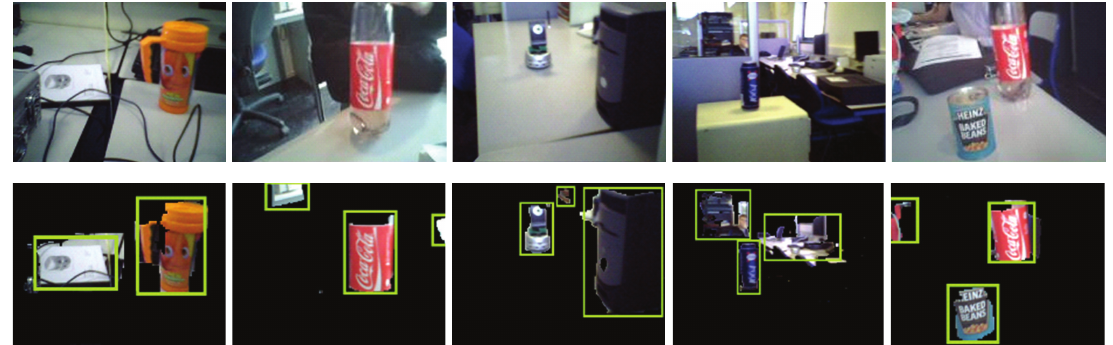
Figure 9: NAO robot camera issued images (upper images) and corresponding salient objects found and segmented by NAO (lower images).